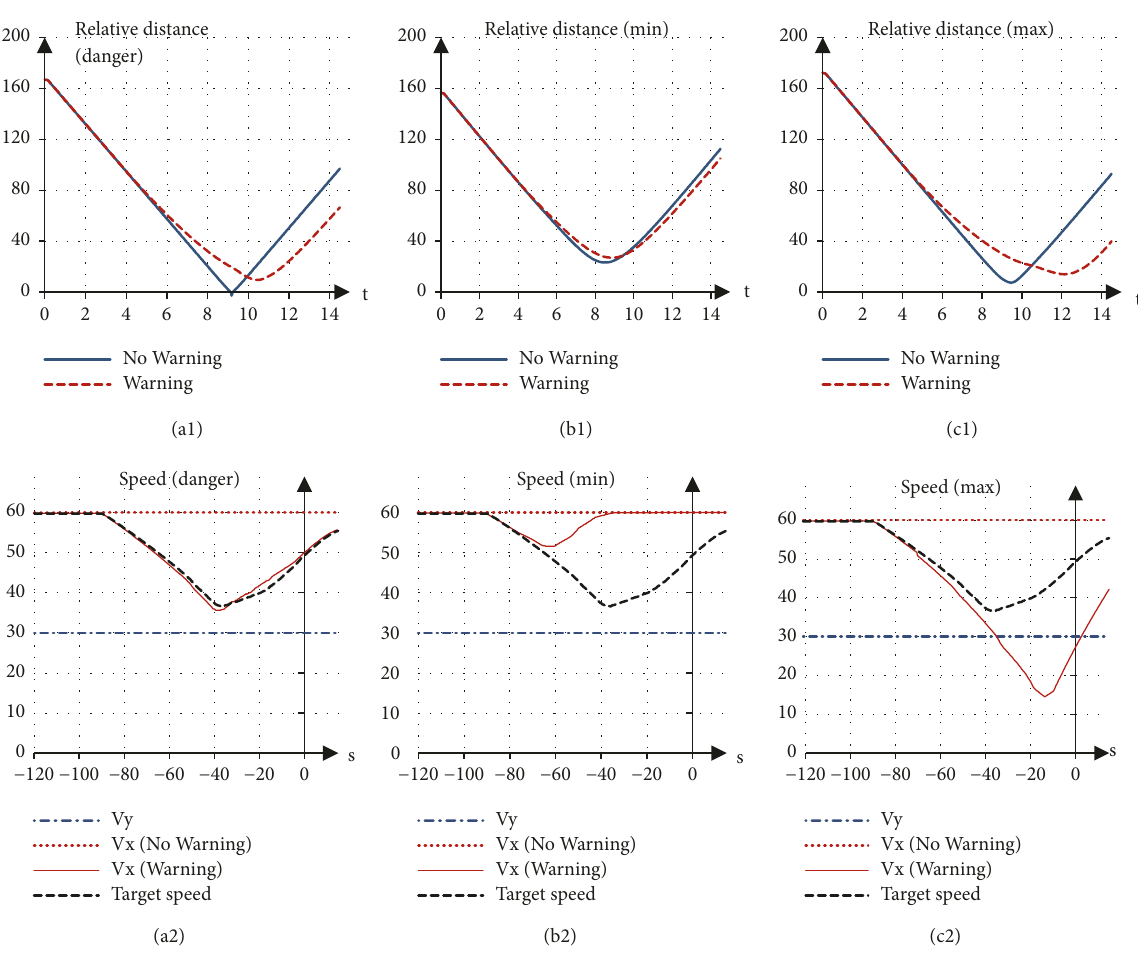
Figure 8: Simulation results (V (c) Y max